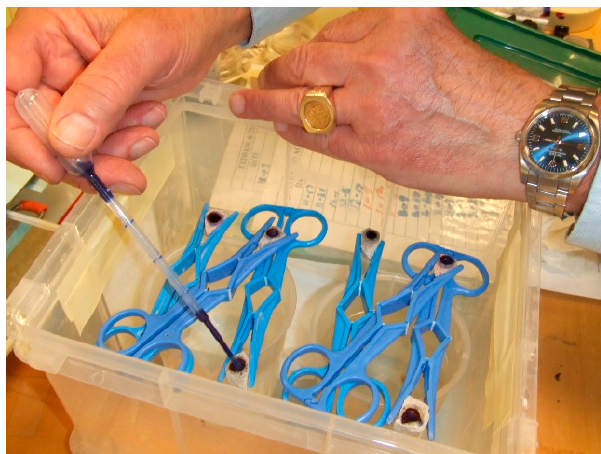
Figure 4. Drops of fountain pen ink being applied to thick slabs of rhyolite in the open humidifying box. Beakers of water to maintain humidity visible at the bottom of box.